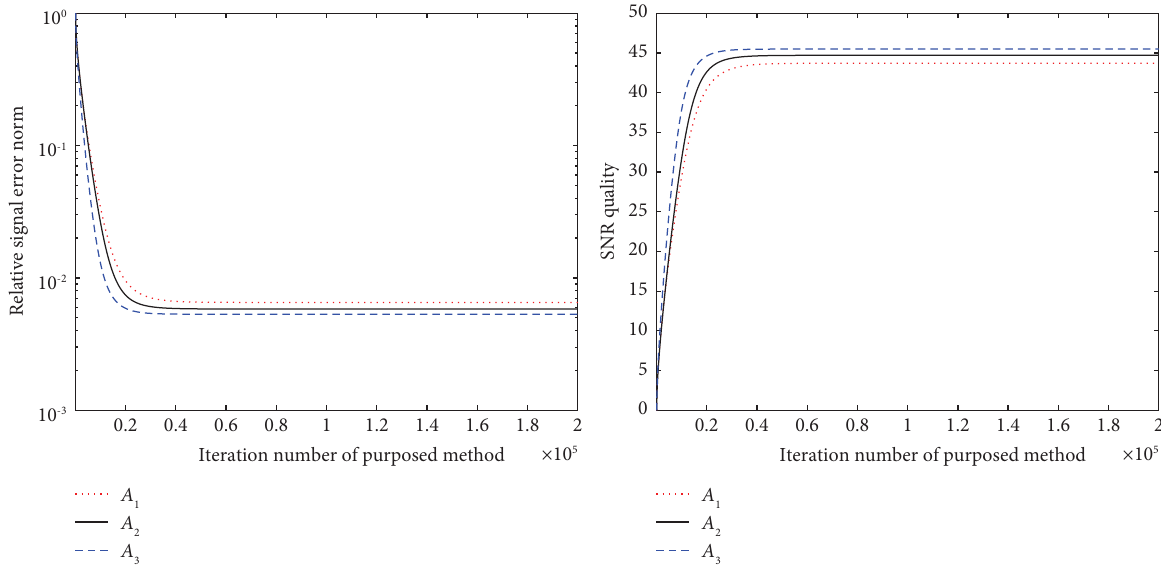
Figure 11: Te relative signal error and SNR plots of the proposed algorithm with the blurring matrices A observed signal with 200 , 000 th iterations.